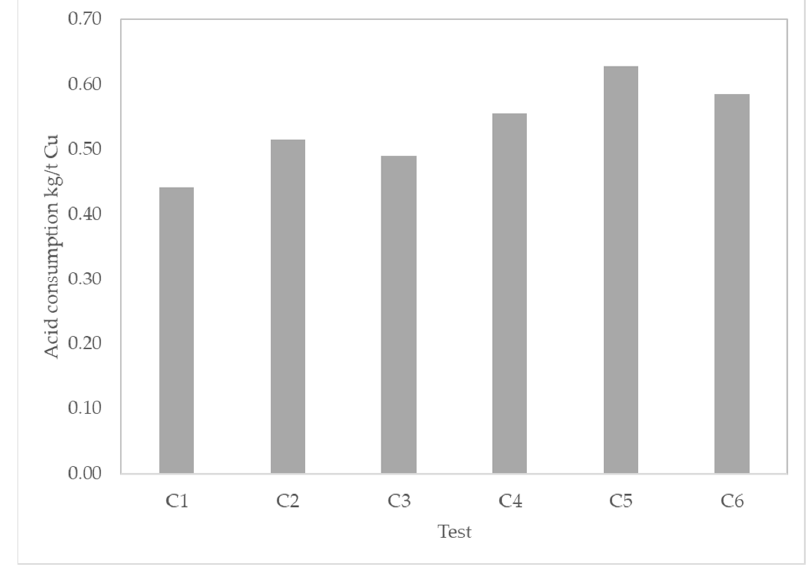
Figure 6. Acid consumption in kg/t Cu for each column in tests C conditions.